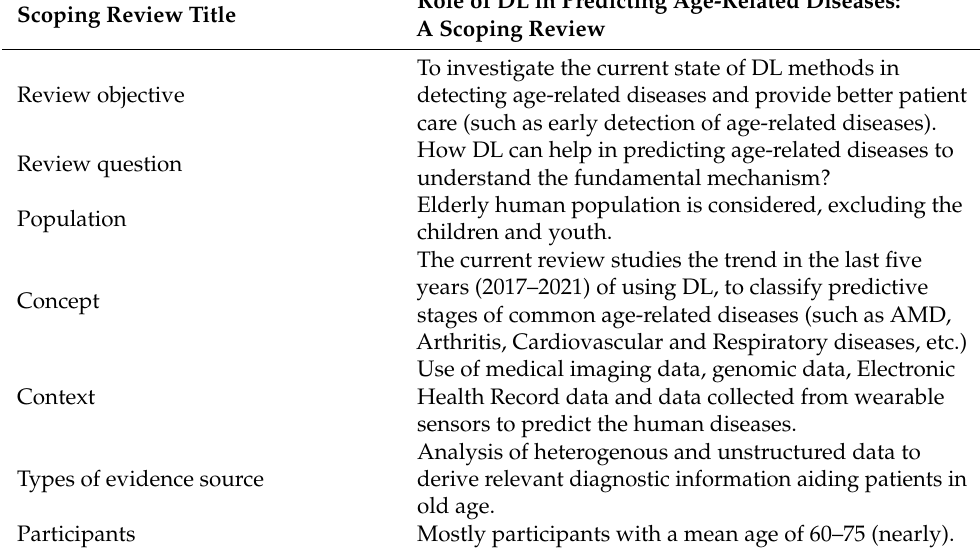
Table 2. The details of scoping